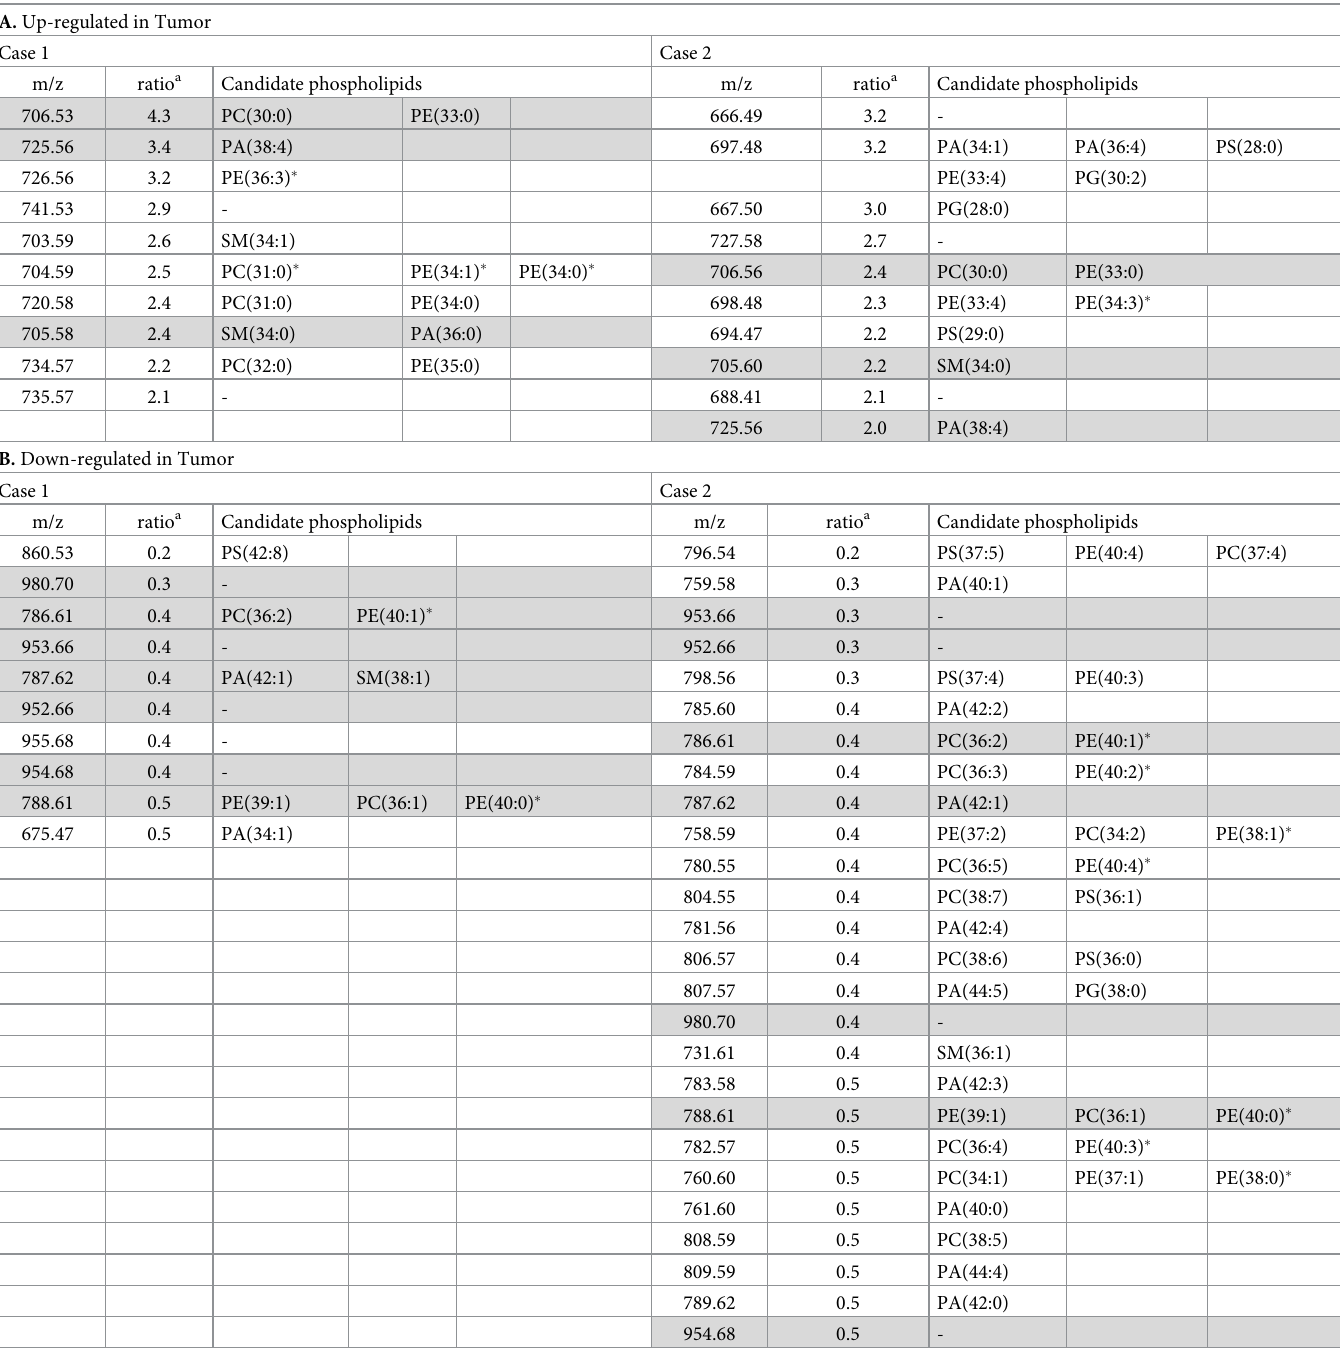
Table 1. Altered peaks identified by MALDI-IMS and corresponding candidate phospholipids in positive ion